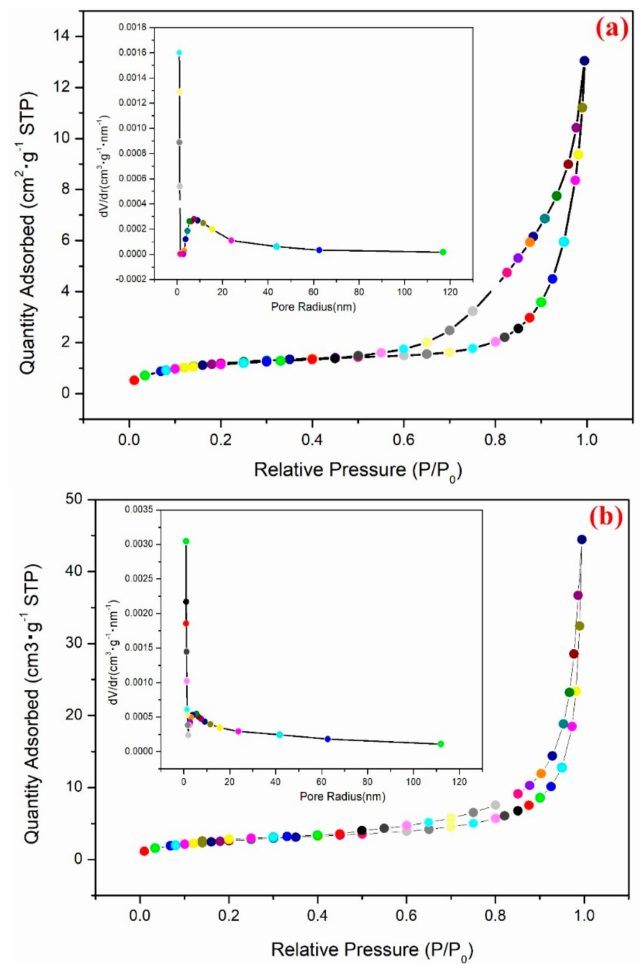
Figure 4. The adsorption–desorption isotherms and the pore size distribution curves (inset). ( a ) BiOCl and ( b ) BiDy 2.0